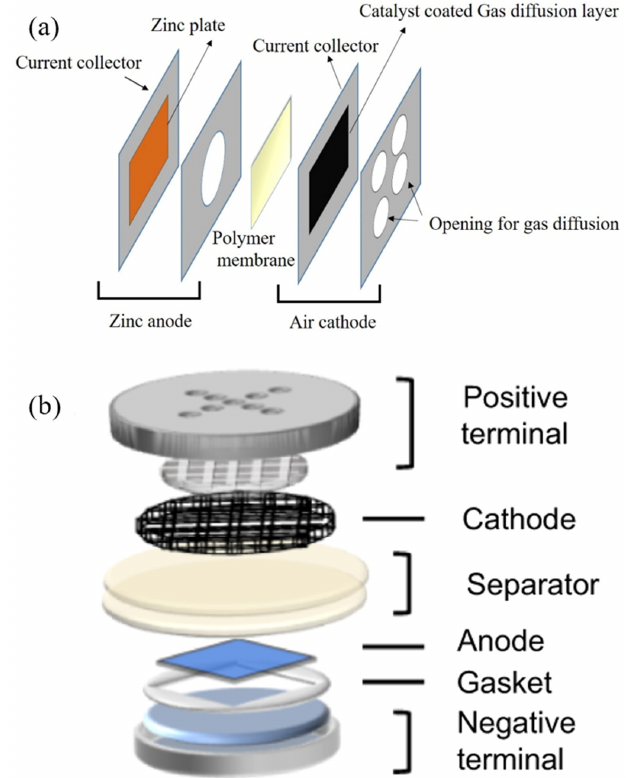
Figure 21. ( a ) Graphic representation of zinc–air battery stack cell configuration. Reprinted with permission from [115]; Copyright 2016, John Wiley and Sons. ( b ) Schematic illustration of the coin cell assembly of the zinc–air battery. Reprinted with permission from Ref. [30] Copyright 2022, Springer Nature.